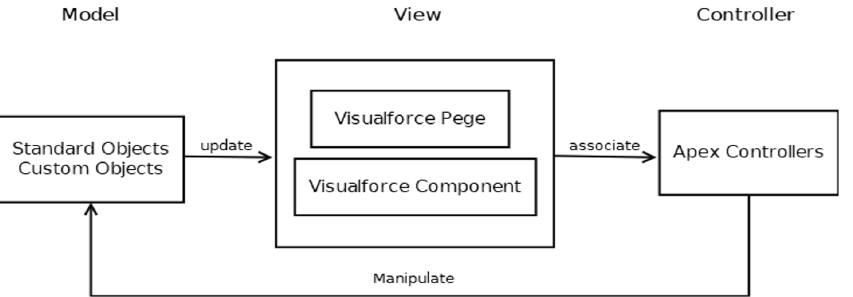
Figure 1. MVC pattern of force.com